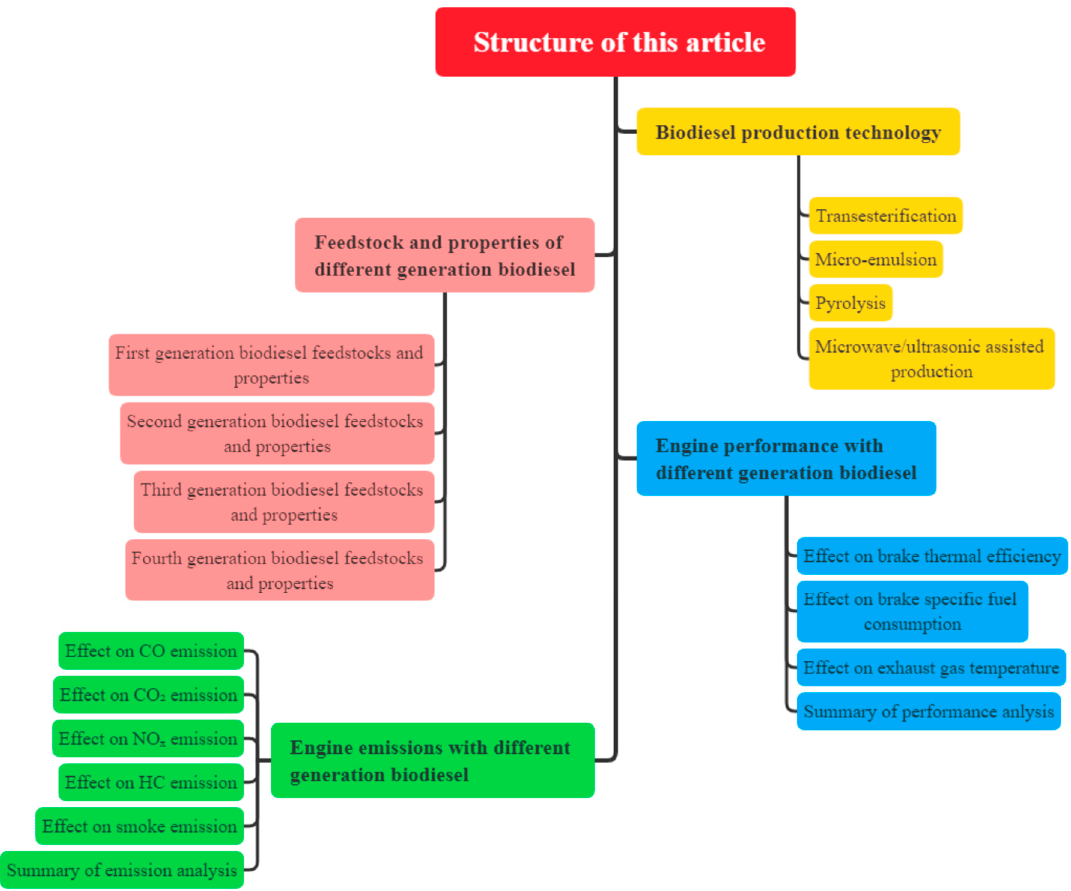
Figure 3. The structure of this